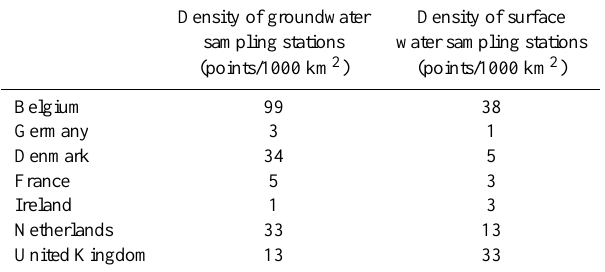
Table 1. Density of groundwater and surface water sampling for the whole land surface in monitoring programs for the NiD (European Commission,